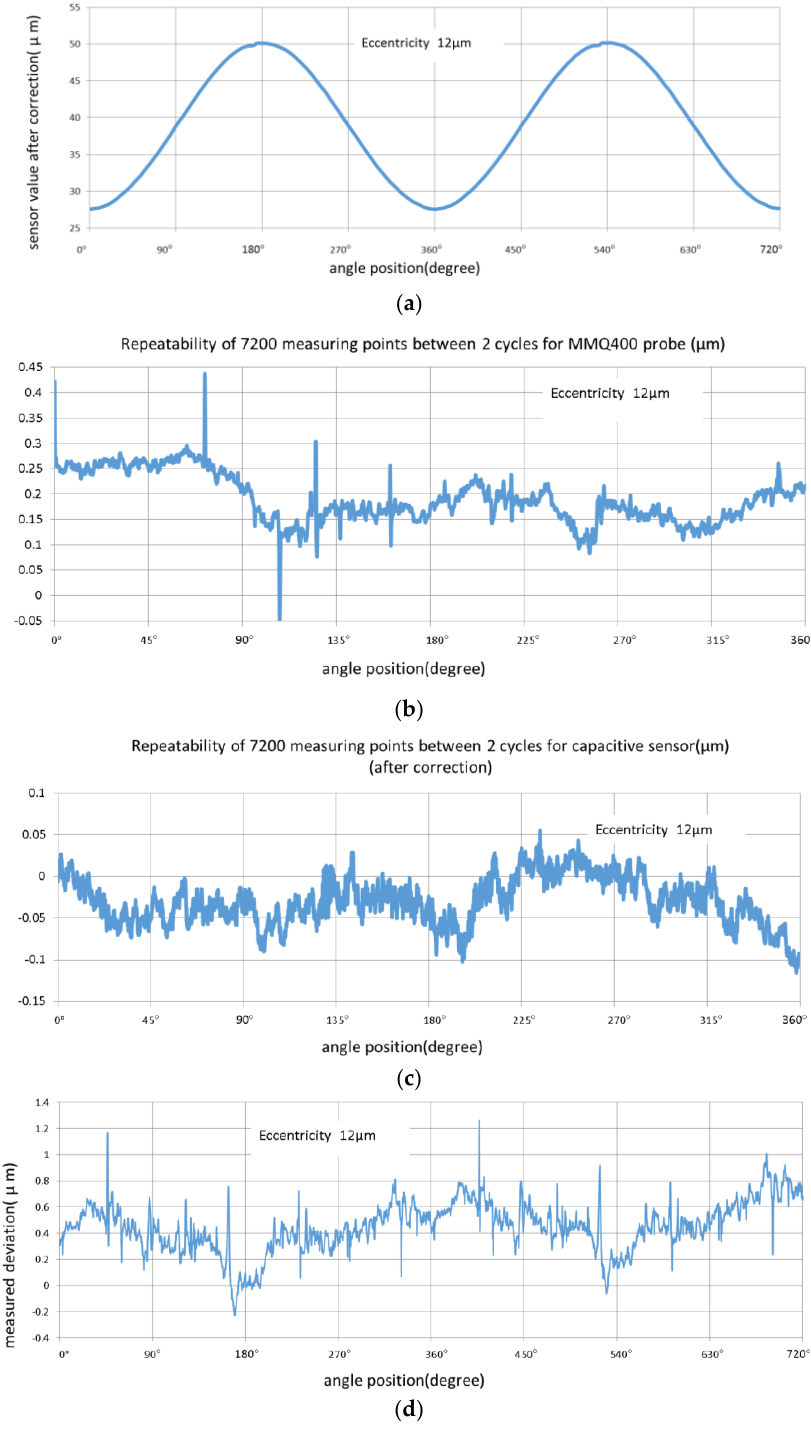
Figure 10. Eccentricity 12 μm measurement with MMQ probe and capacitive sensor: ( a ) Capacitance sensor values after nonlinear correction in two cycles; ( b ) Repeatability of 7200 measuring points between two cycles for MMQ probe; ( c ) Repeatability of 7200 measuring points between two cycles for capacitance sensor; and ( d ) Measured deviations between capacitance sensor and MMQ400 probe.